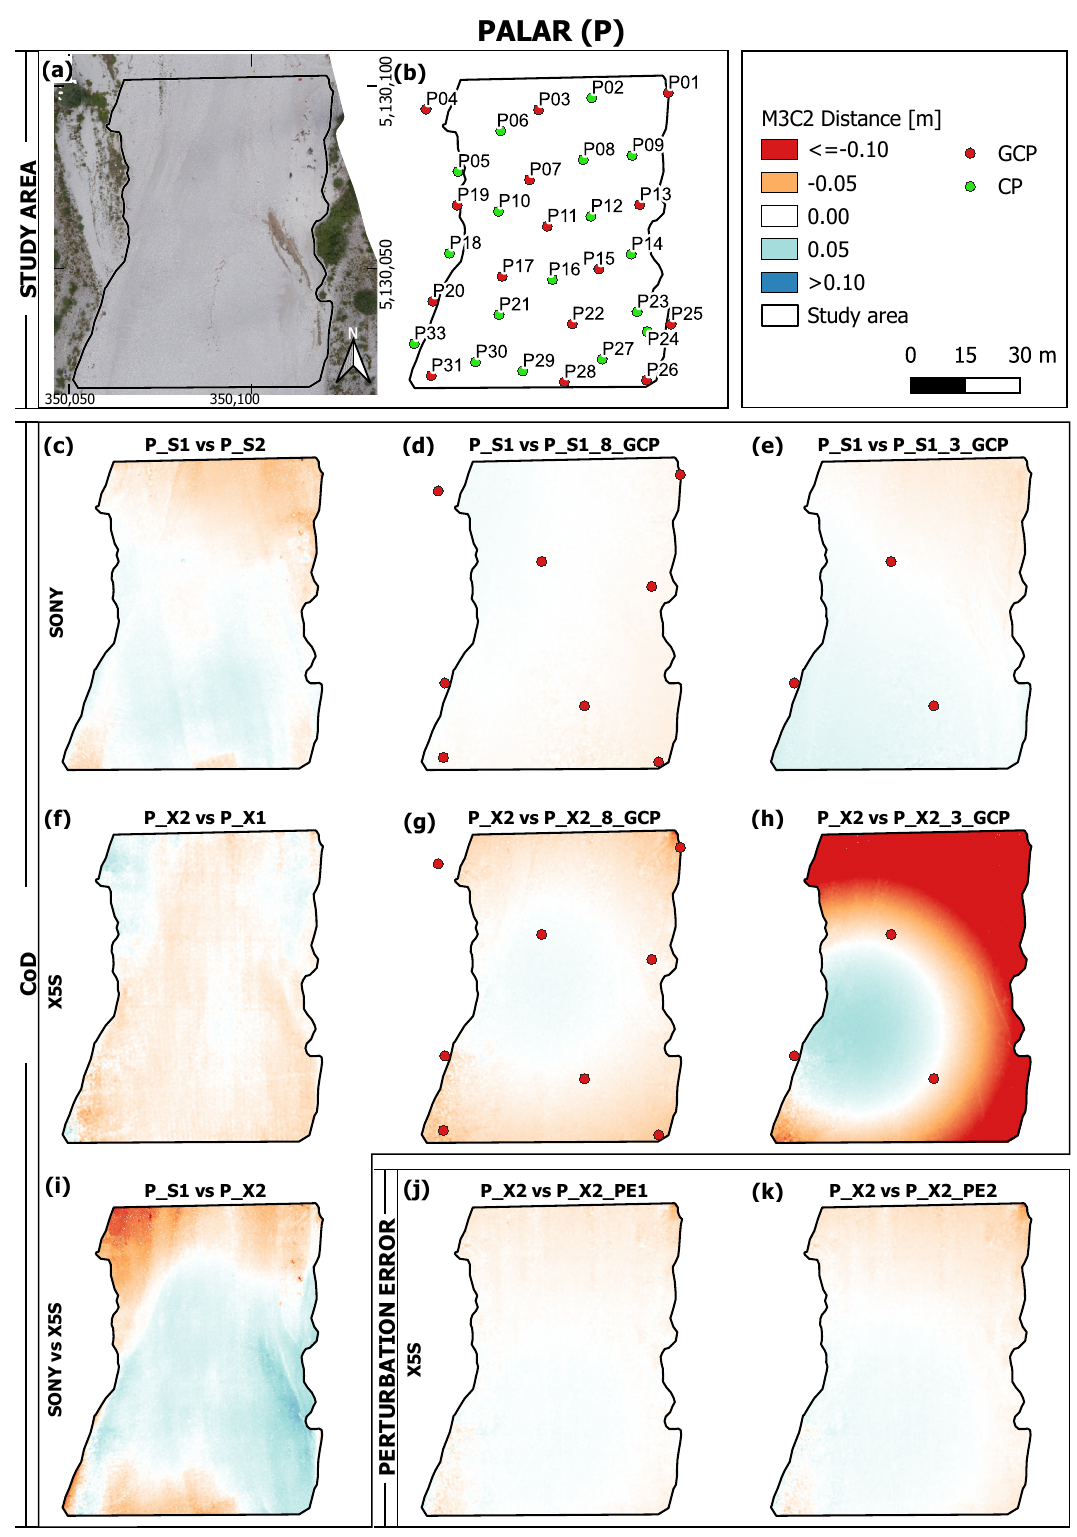
Figure 3. CoDs of Palar models obtained using different cameras, different number of GCPs and varying GCP coordinate precision. ( a ) Study area. ( b ) GCPs (red) and CPs (green) positions. ( c , f , i ) CoDs derived from Sony and X5S point clouds, exploiting all available GCPs in the bundle adjustment. Comparisons between the reference point cloud and those obtained with 8 and 3 GCPs are reported in ( d , e ) for Sony image set and ( g , h ) for X5S camera. In ( j , k ) the effect of two levels of perturbation error introduced in the GCP coordinates are shown for X5S camera. Distance values are pictured with a red-to-blue